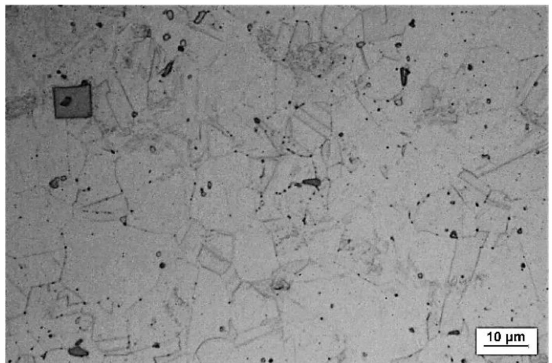
Figure 3. Optical micrograph of steel 1.4305; as-received material, soft annealed and cold drawn, cross-section of the specimen, aqua regia, 1000 ˆ